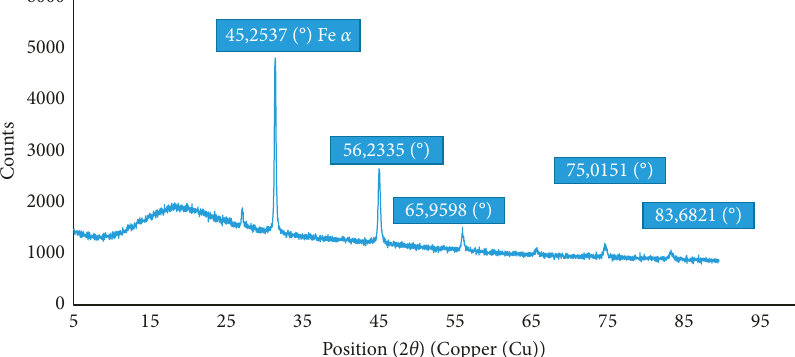
Figure 3: XRD pattern of iron nanoparticles prepared with mortiño berry (vZVI).